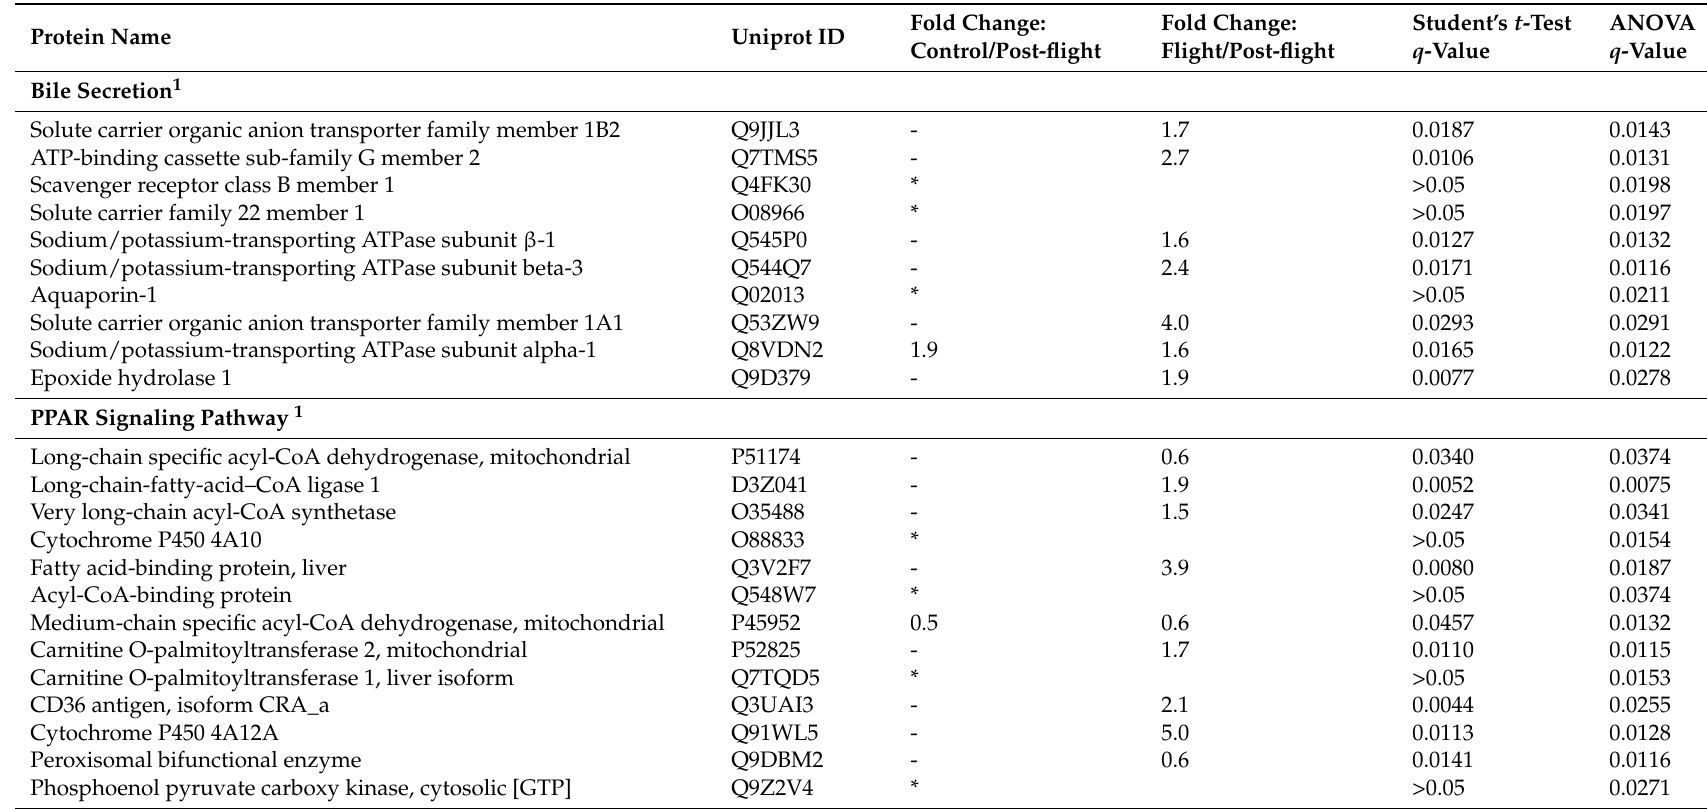
Table 2. Fold-change of proteins annotated against KEGG